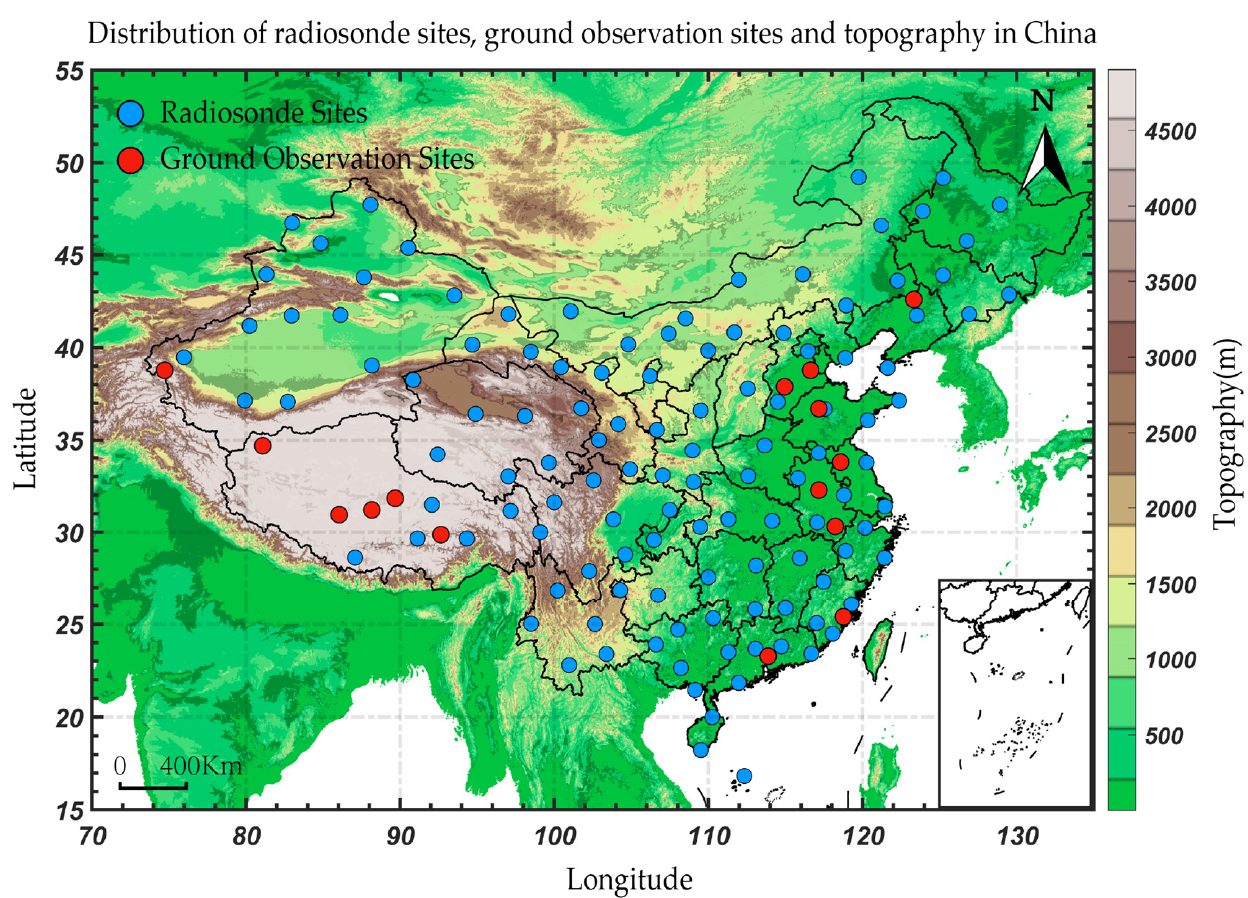
Figure 1. Distribution of radiosonde sites ( blue dots ), ground observation sites ( red dots ), and topography (shading) in China.